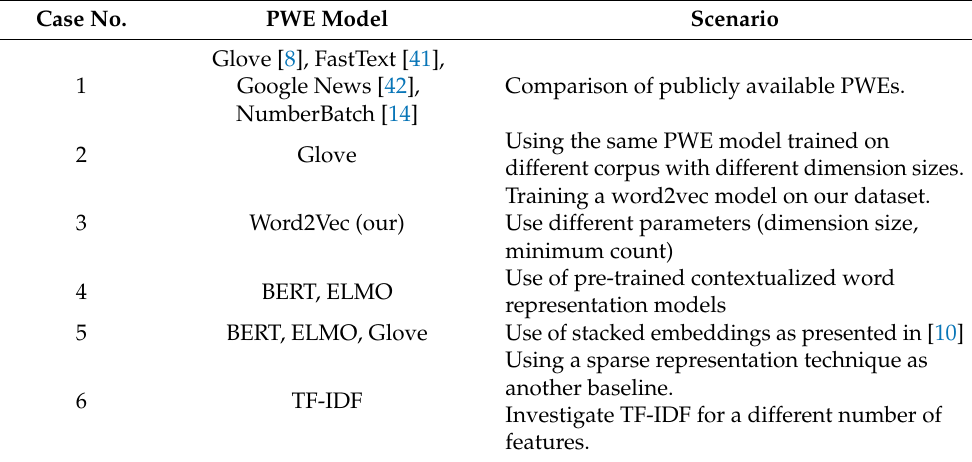
Table 8. Experimental setup #3.